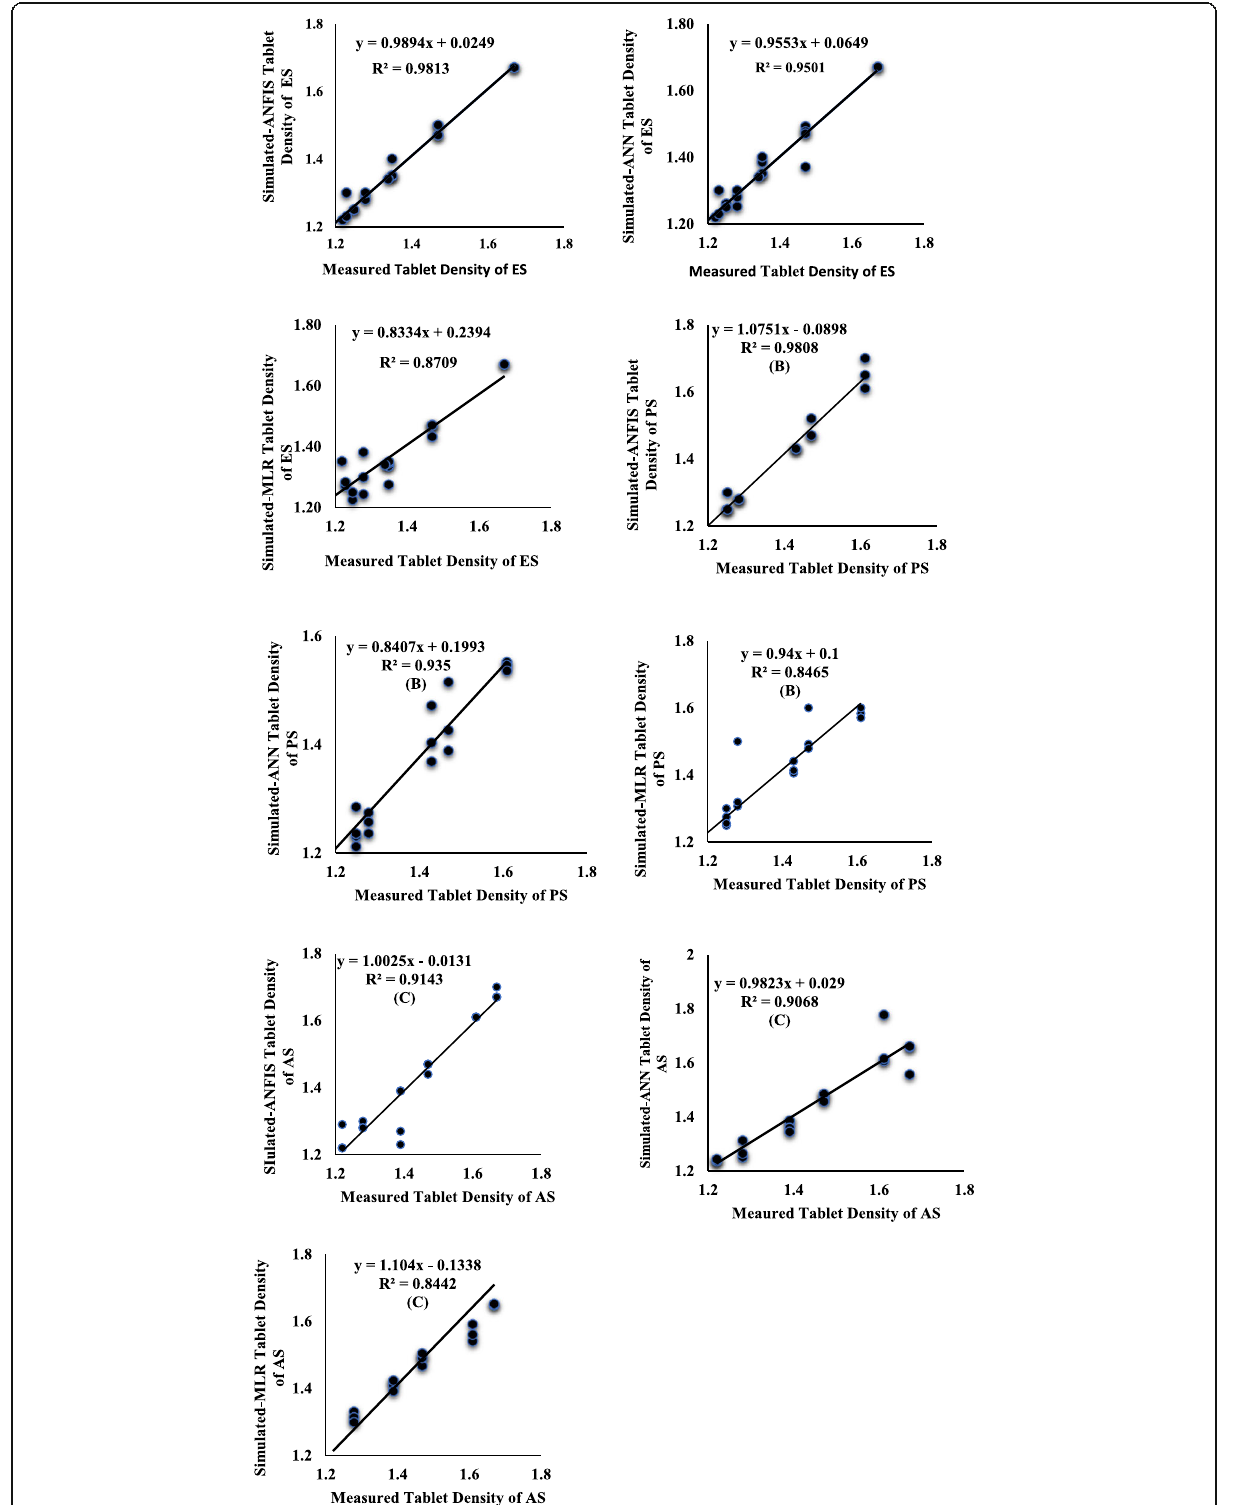
Fig. 5 Scatter plots of tablet compact densities for ANN, ANFIS, and MLR. a ES. b PS. c